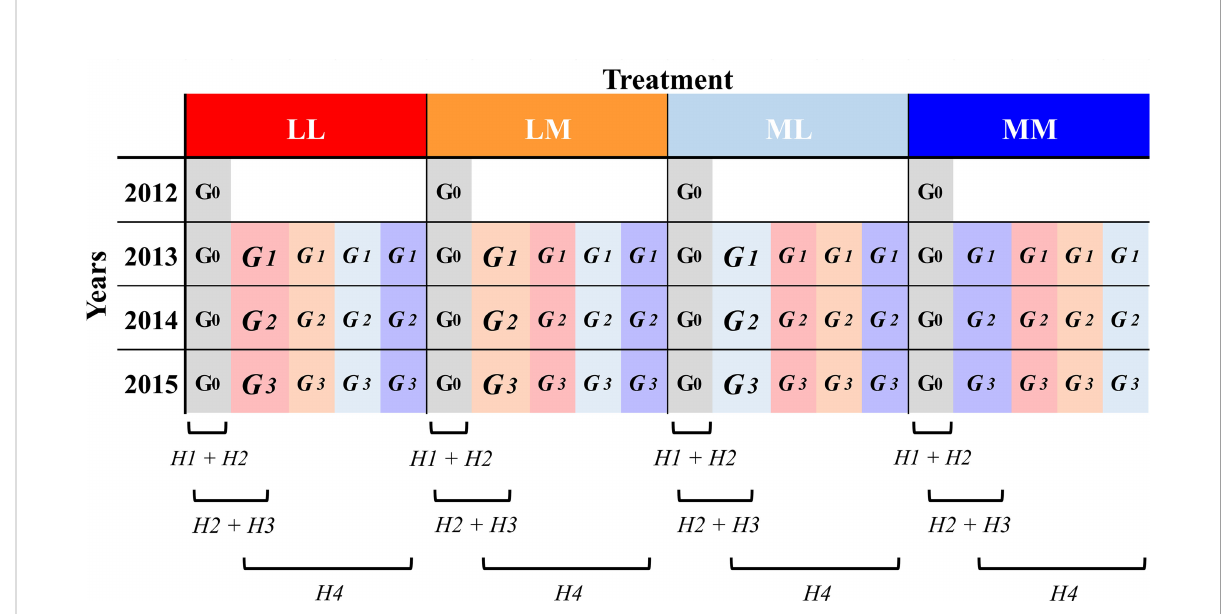
FIGURE 1 Design of the evolution experiment. Ancestors (G 0 ) and the three descendant generations (G 1-3 ) were subjected to four different precipitation predictability treatment combinations (LL, LM, ML, MM; see methods) in their year of growth ( i.e. , Treatment). Ancestors (in grey) were grown from 2012 to 2015 and descendants (highlighted in the maternal treatment colour but lighter than the treatment in the growing year) from 2013 to 2015. Below, the brackets refer to the experimental lines ( i.e. , generation and treatment) involved in the assessment of each of the four main hypothesis ( H ) we addressed in this work ( see